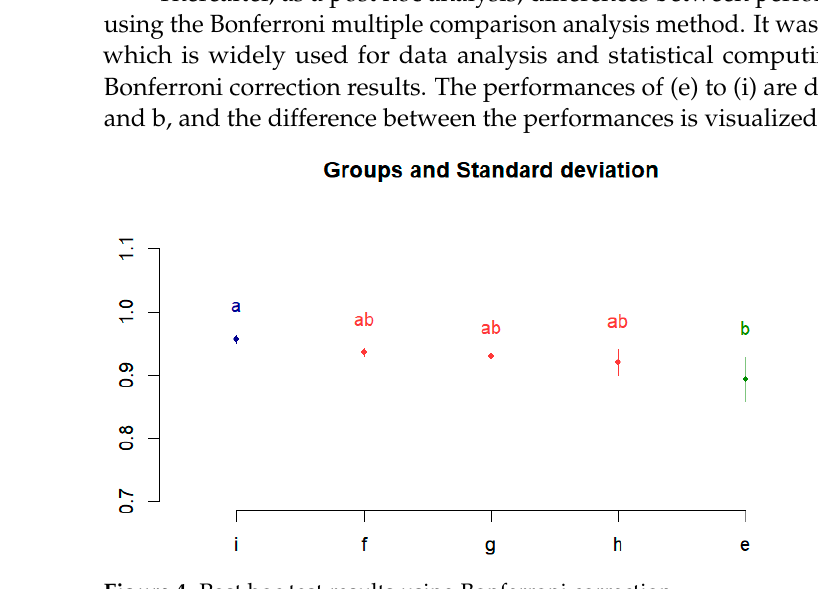
Figure 4. Post hoc test results using Bonferroni correction.